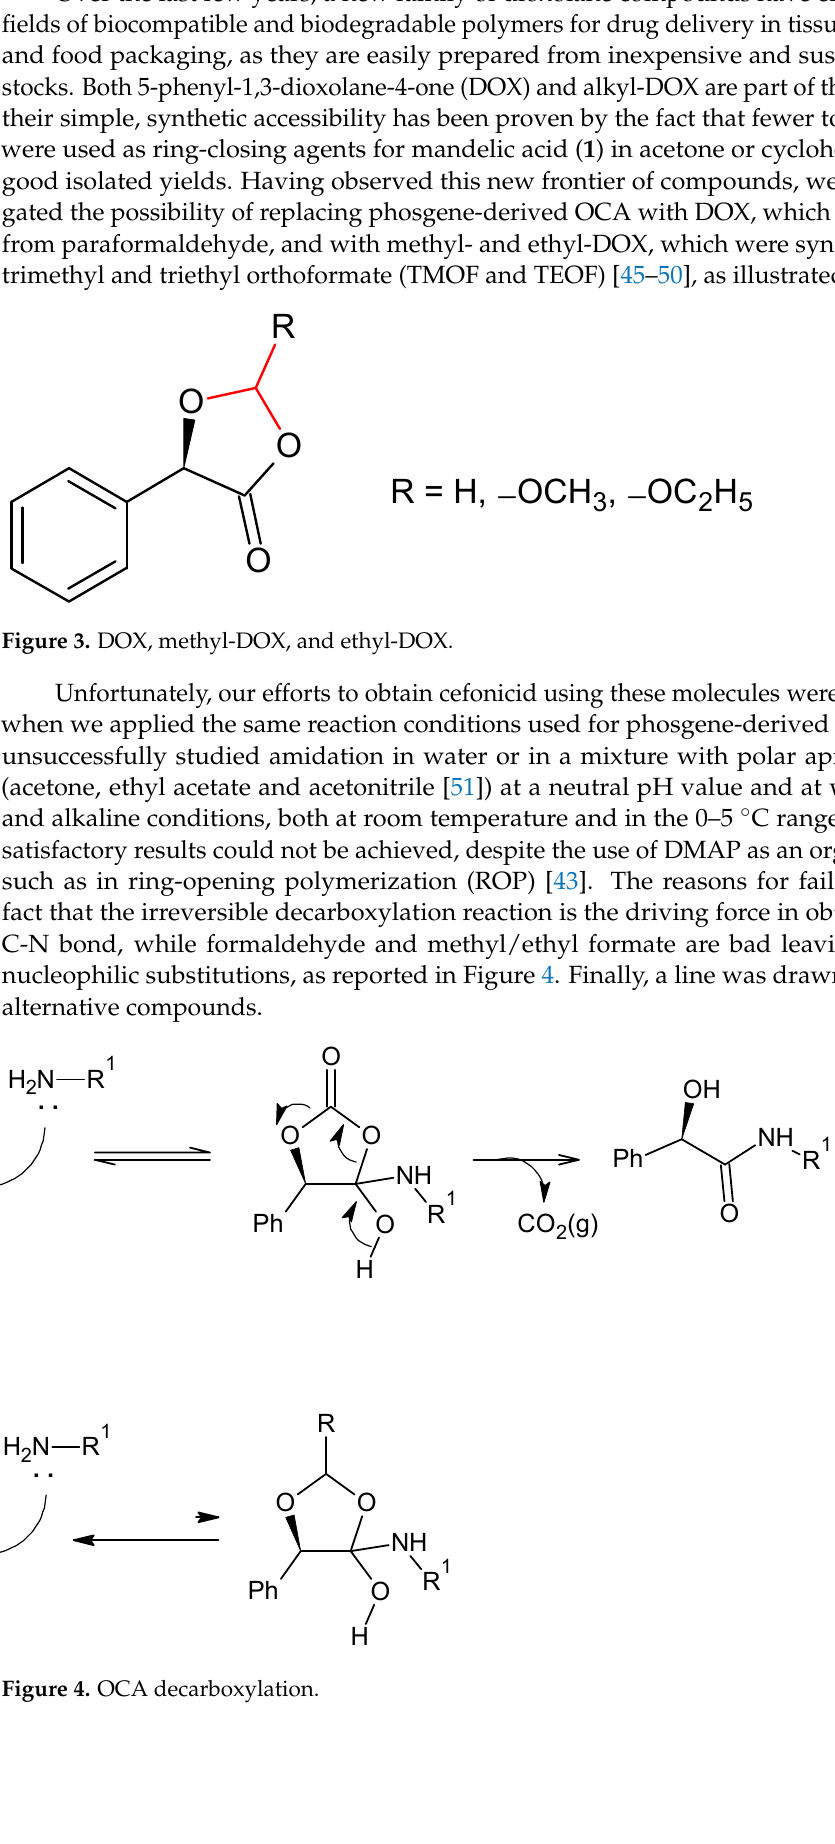
4 of 14 Figure 2. Amidation of OCA ( 2 ) from ( R )-mandelic acid ( 1 ) and 7-SACA or 7-TACA intermediate ( 3 ).